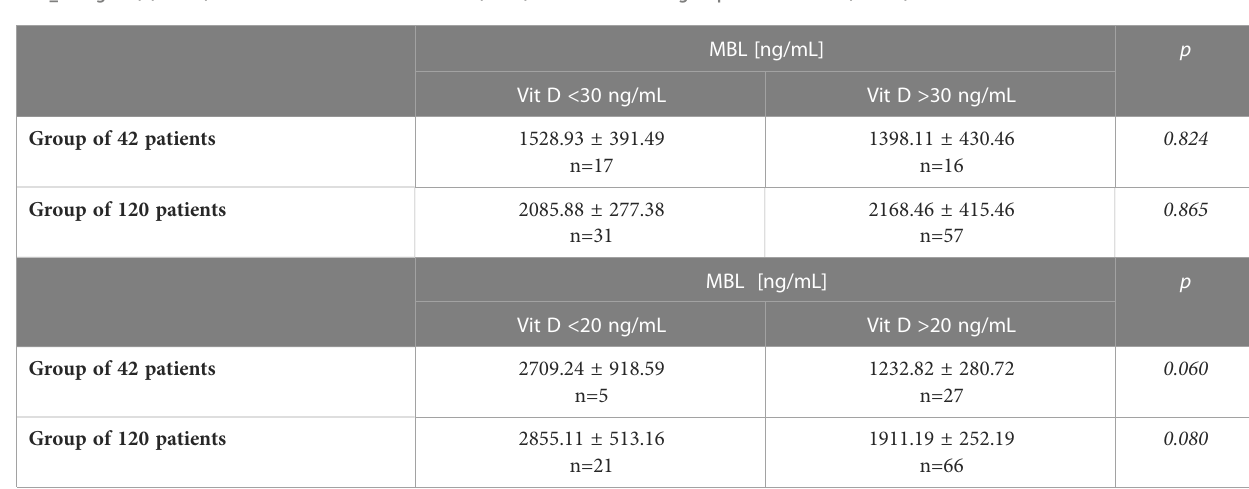
TABLE 7 Mean MBL concentration in patients with/without Vit. D de fi ciency (<30 ng/mL/ ≥ 30 ng/mL) (above) or severe vitamin D de fi ciency (<20 ng/ mL/ ≥ 20 ng/mL) (below) evaluated in control individuals (n=21) and in the whole group of individuals